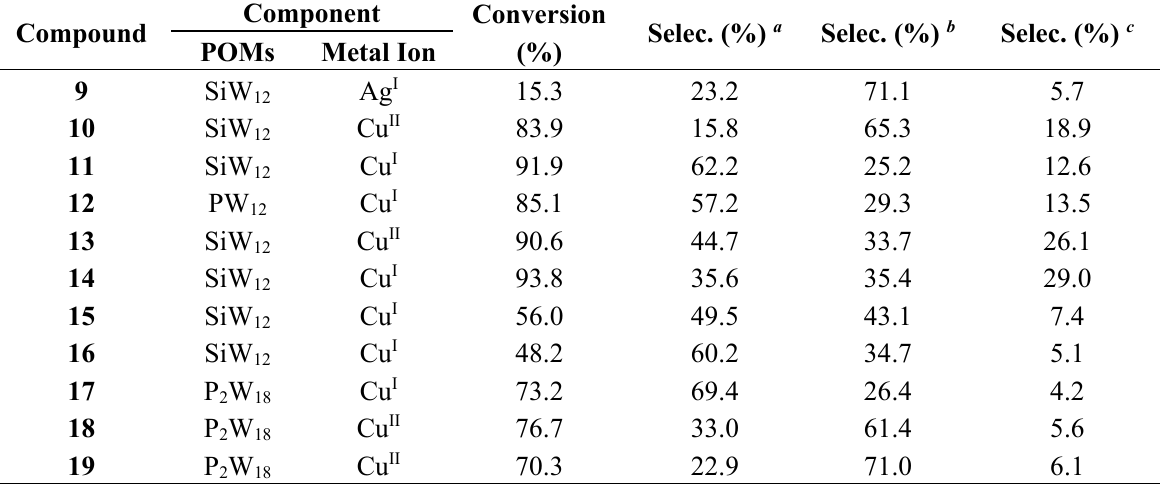
Figure 8. ( a – d ) Polyhedral and ball-and-stick representation for compounds 13 – 16 . Table 2. The catalytic results for epoxidation of styrene over compounds 9 – 19